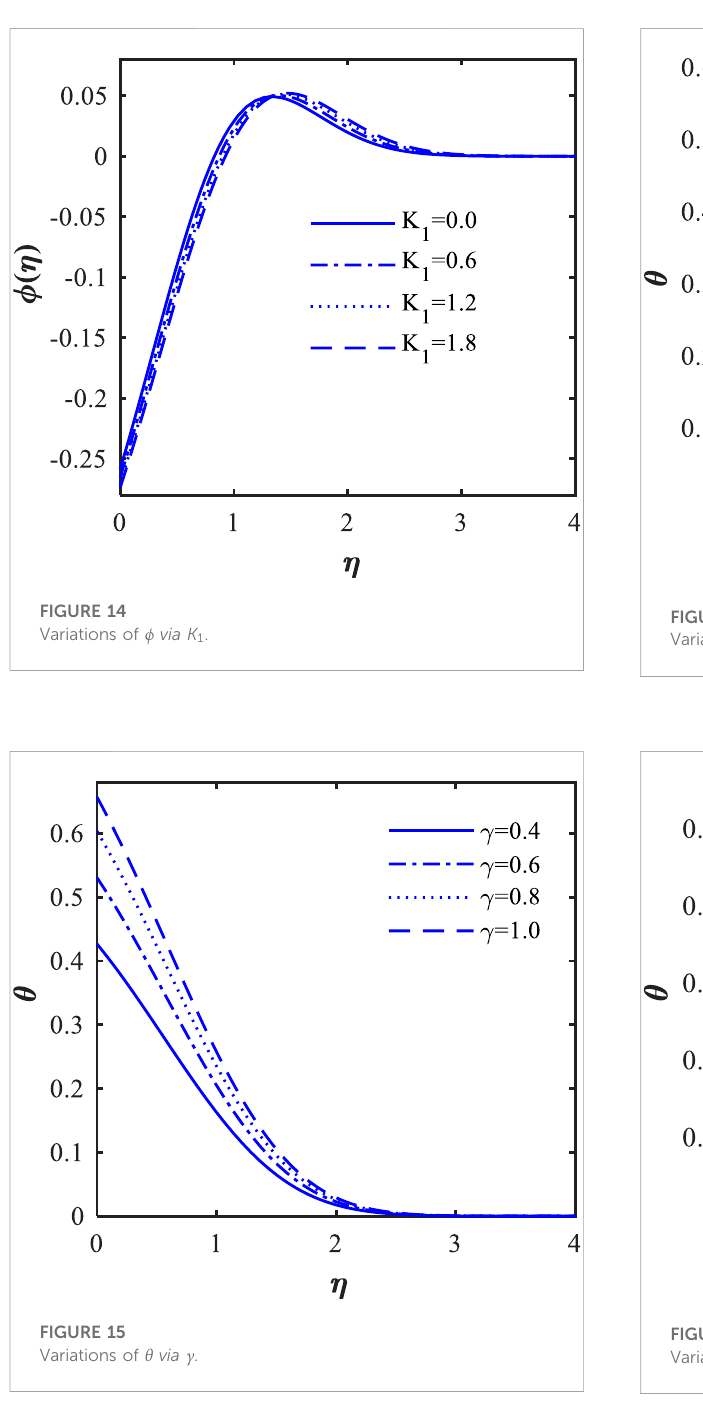
FIGURE 15 Variations of θ via γ .